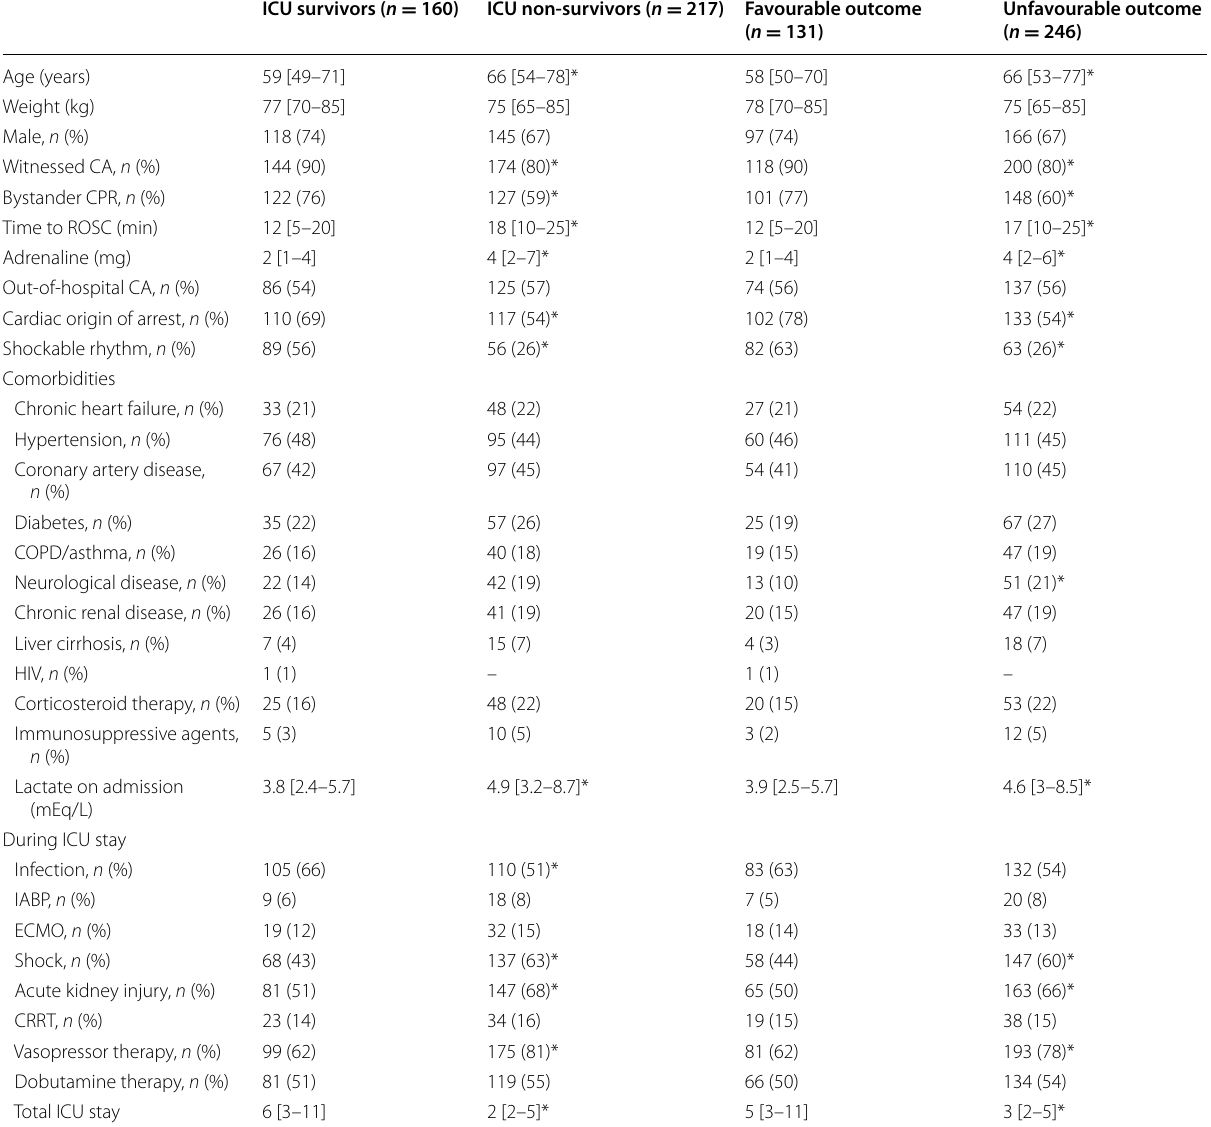
CA cardiac arrest, CPR cardiopulmonary resuscitation, ROSC return of spontaneous circulation, COPD chronic obstructive pulmonary disease, IABP intra-aortic balloon pump counterpulsation, ECMO extracorporeal membrane oxygenation, CRRT continuous renal replacement therapy, ICU intensive care unit, HIV human immunodeficiency virus * p < 0.05 in survivors versus non-survivors OR favourable versus unfavourable